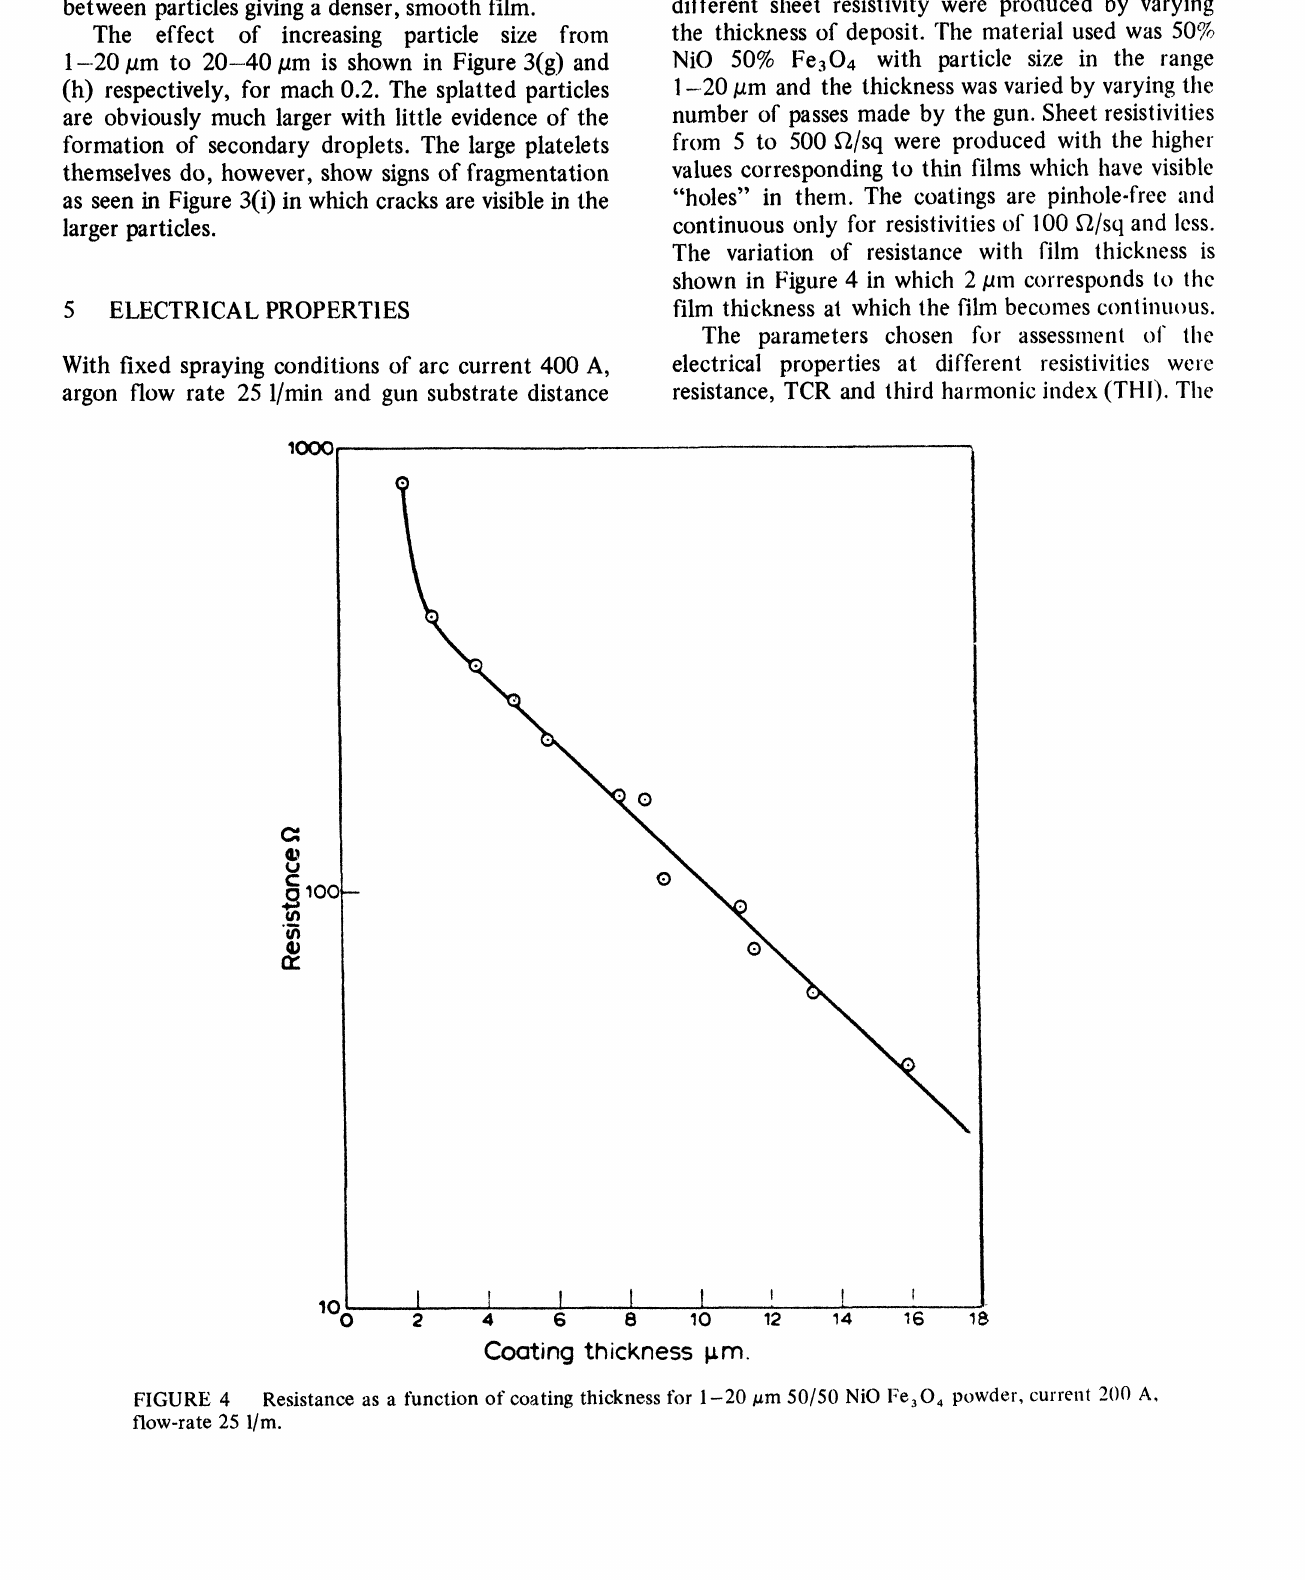
FIGURE 4 Resistance as a function of coating thickness for 1-20 m 50/50 NiO l;’e304 powder, current 200 A, flow-rate 25